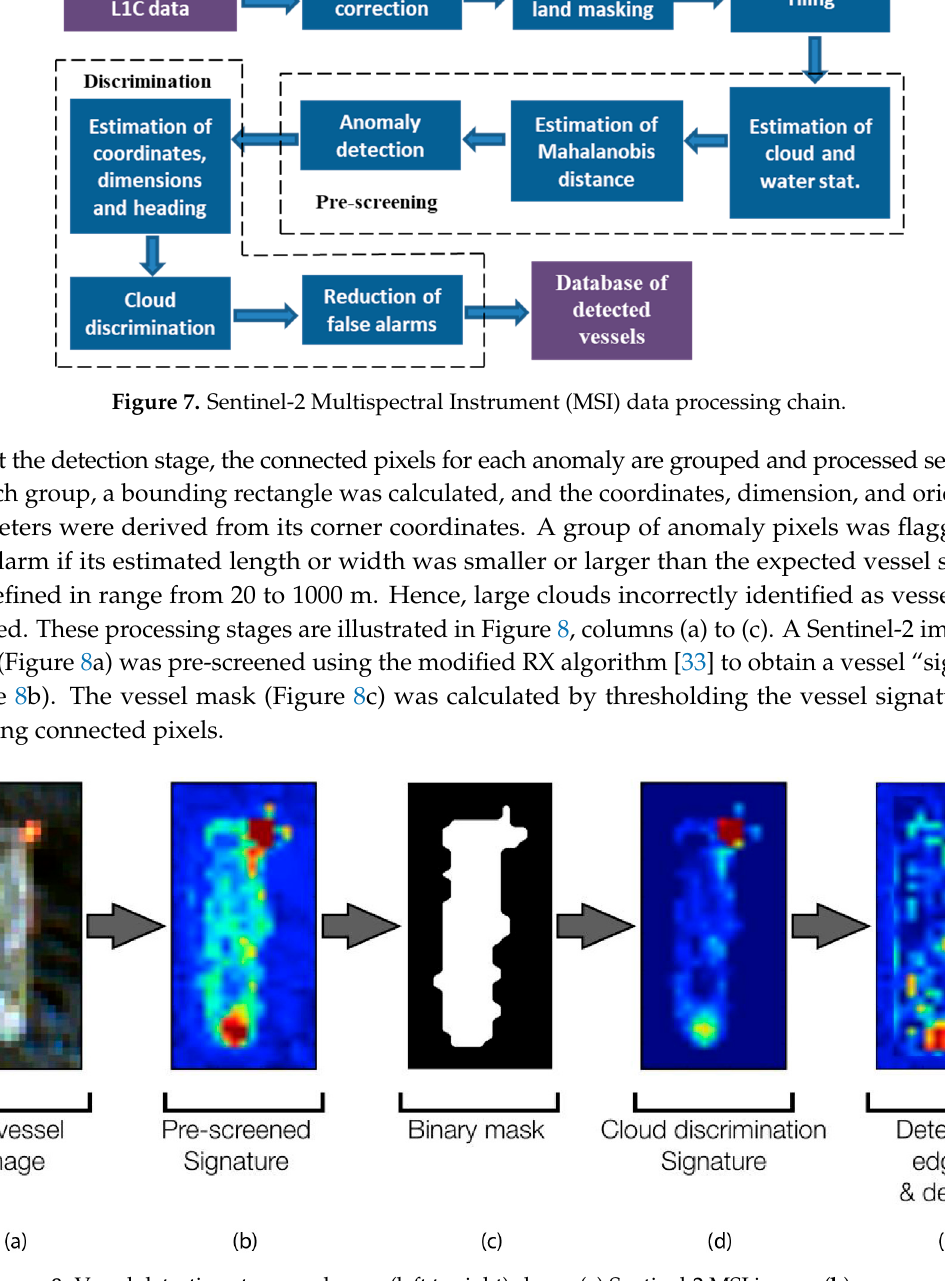
(b) Figure 6. Automatic vessel detection: ( a ) vessels at the entrance to Port Tema, Ghana (example